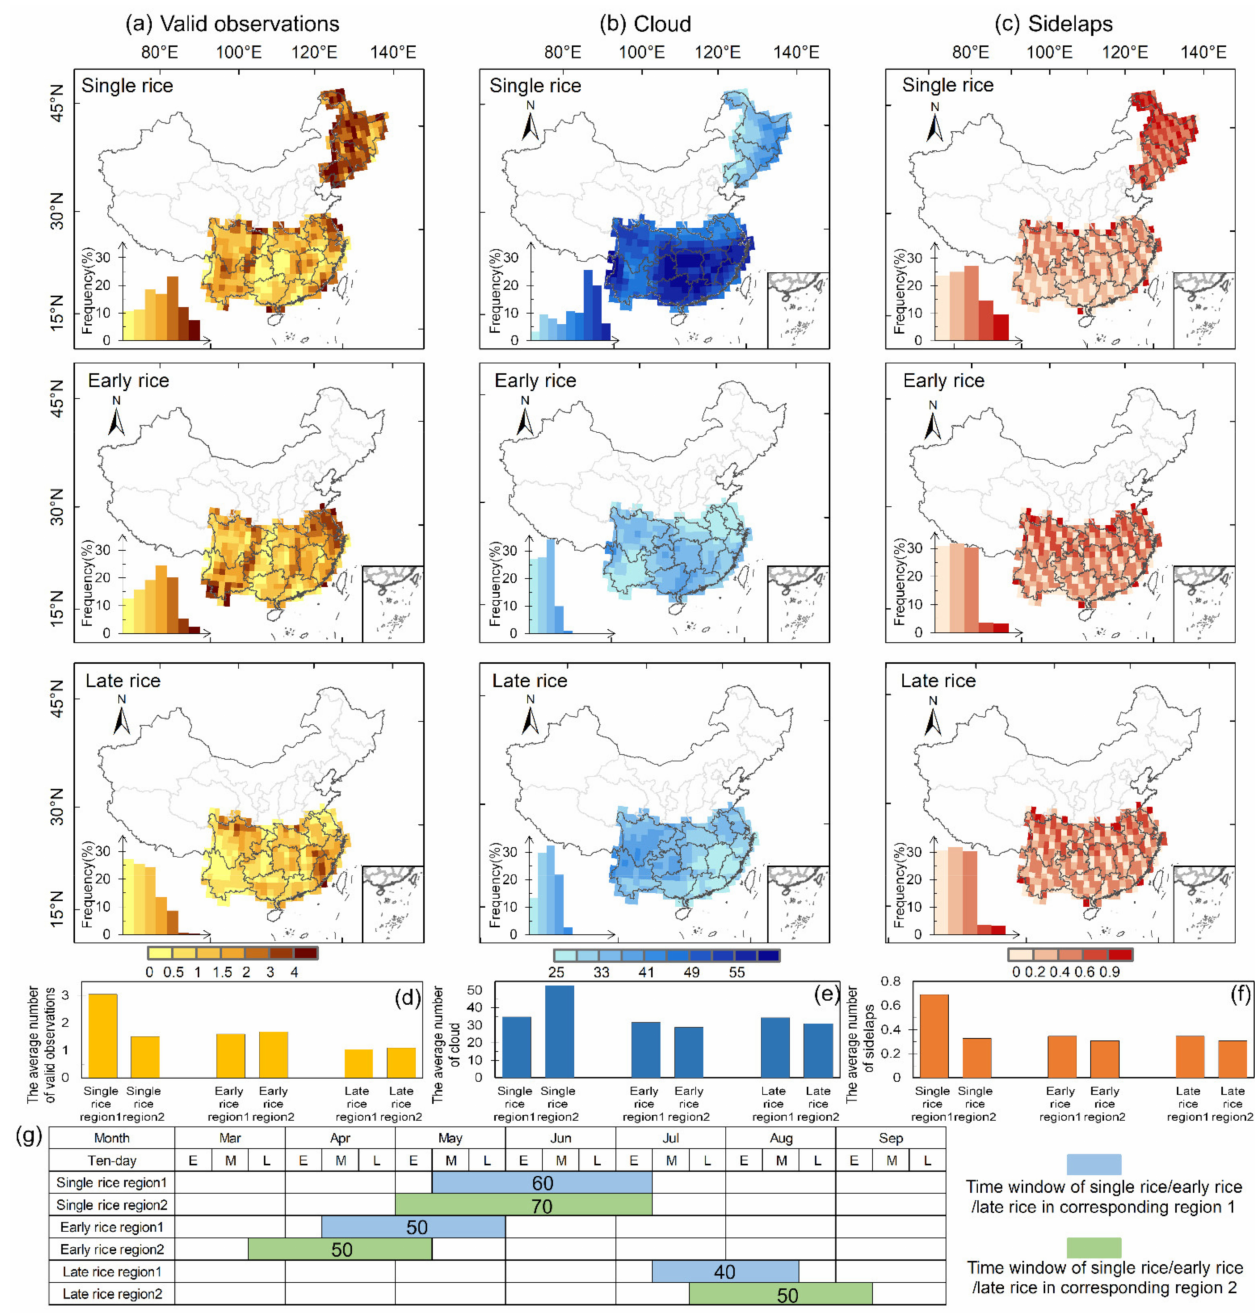
Figure 5. The spatial distributions and the average number of valid Landsat-8 observations ( a,d ), cloud ( b,e ), and overlap ( c,f ) during the period with flooding signals of single rice, early rice, and late rice at 1 ◦ × 1 ◦ grids; ( g ) shows the start, end, and length of the time window with flooding signals of rice paddies as determined in Section 3.1. The insets in ( a–c ) are the corresponding frequency